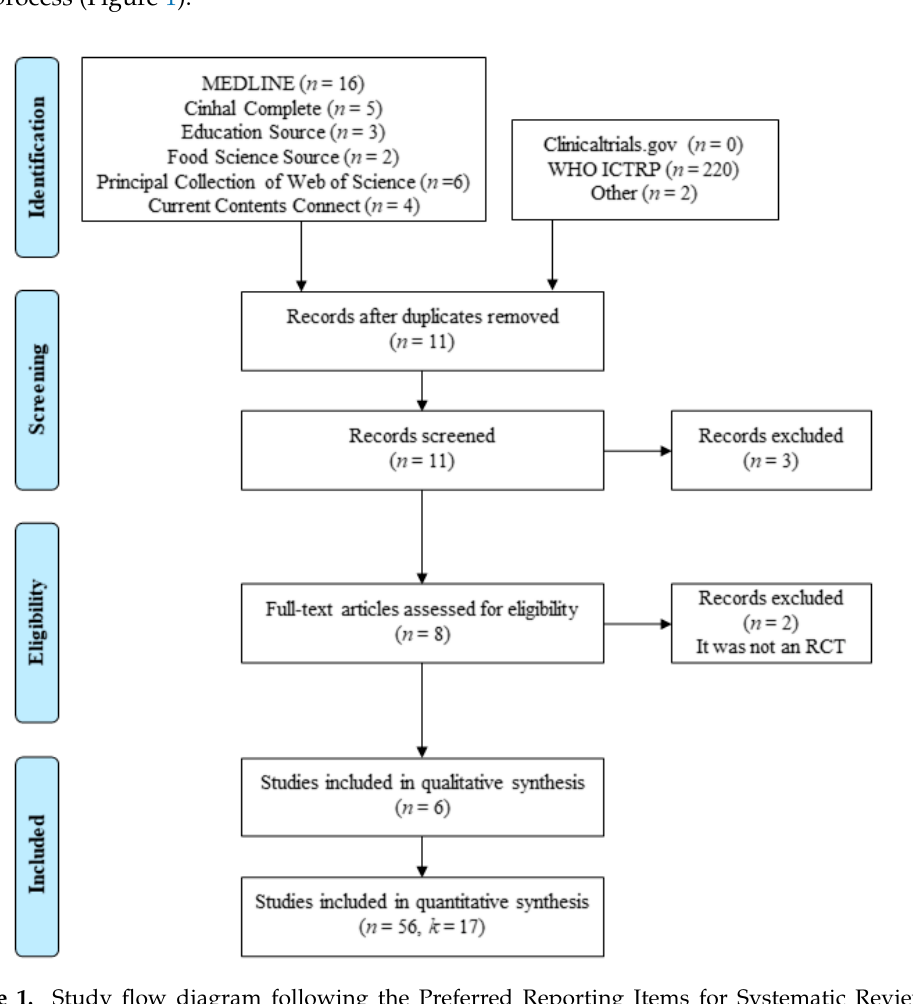
Figure 1. Study flow diagram following the Preferred Reporting Items for Systematic Reviews and Meta-Analyses Guidelines [31], where n is the number of papers and k is the number of individual studies.